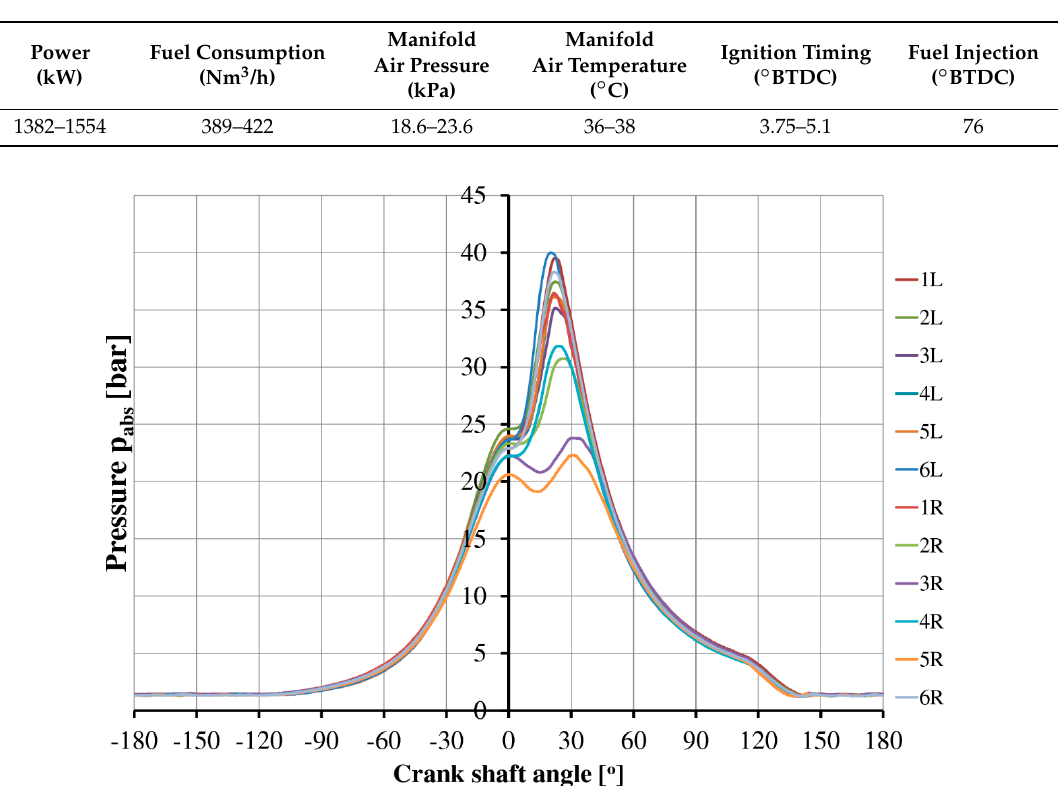
Figure 4. Indicated mean effective pressure for 12 cylinders of the GMVH-12 engine, rotational speed 300 rpm, spark plug ignition system.